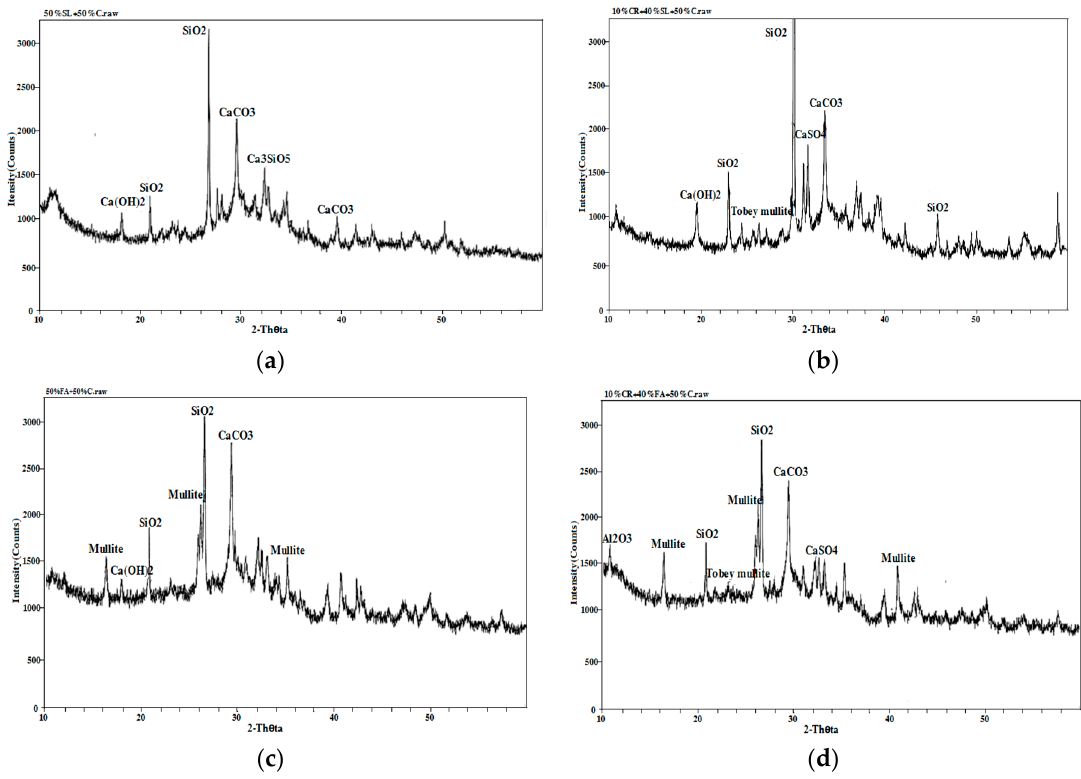
Figure 15. XRD maps of different concrete specimens: ( a ) 50% slag and 50% cement; ( b ) 10% coke residue, 40% slag, and 50% cement; ( c ) 50% fly ash and 50% cement; ( d ) 10% coke residue, 40% fly ash, and 50% cement.